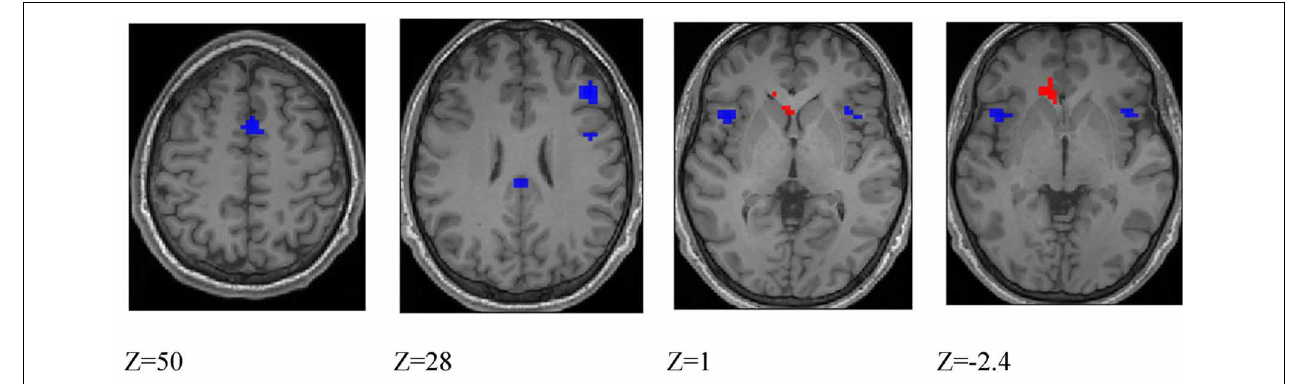
FIGURE 6 | Blue colored voxels indicate regions where activation is significantly greater for deception identification than for direction identification, and red voxels indicate regions that respond more to direction identification than deception identification. z = 50; medial